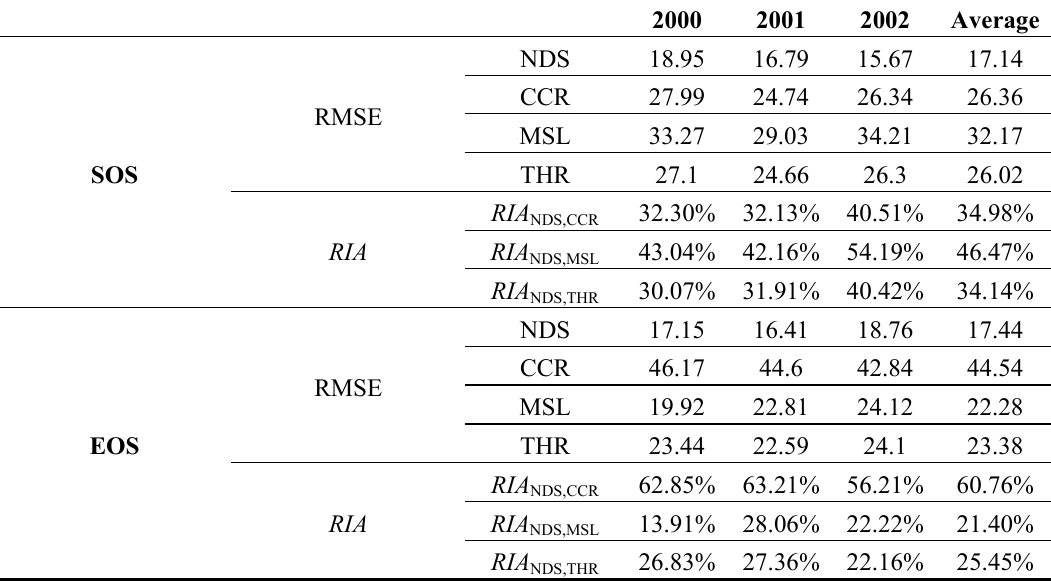
Table 3. RMSE for all four methods and the relative accuracies (RIA) of NDS to the three other methods, for SOS and